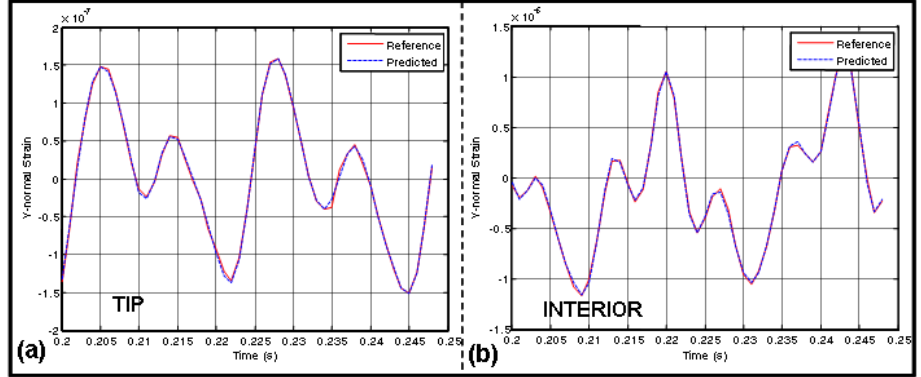
Fig. 6. Overlay of strain response of box-beam at (a) tip and (b) interior location; predicted solution used first 10 modes in expansion process.